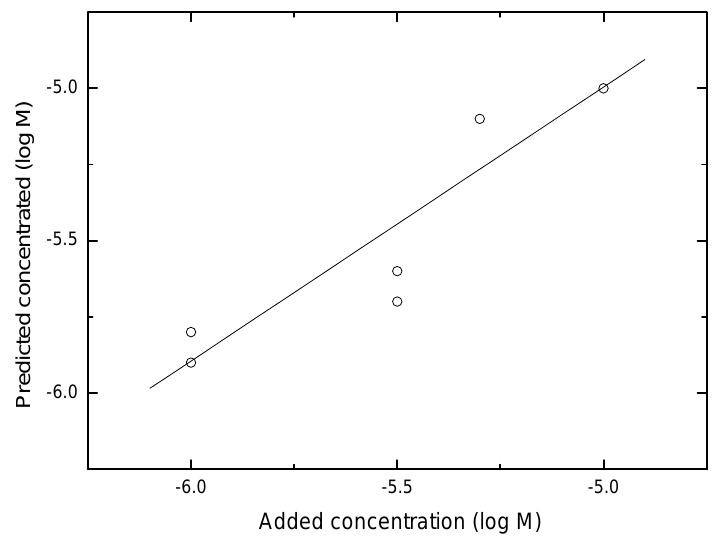
Figure 11. Calibration curve (12 samples) of phenolate in test mixtures of key odorants containing ammonium at pH 8. BPNN used 4, 4, 1